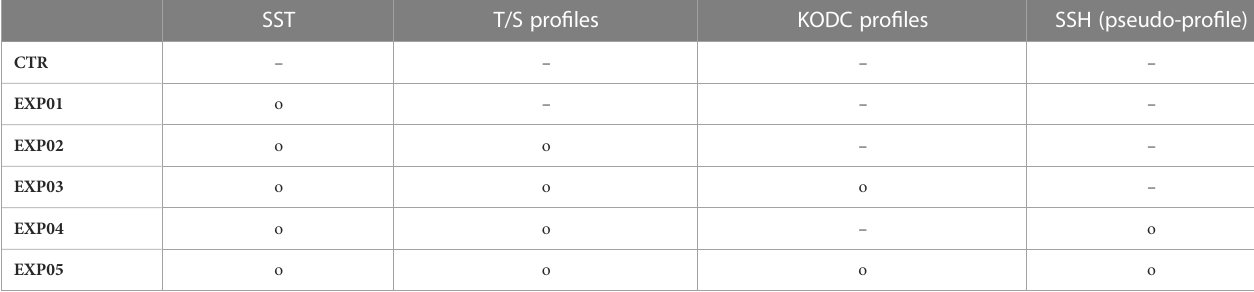
TABLE 1 Summary of the sensitivity